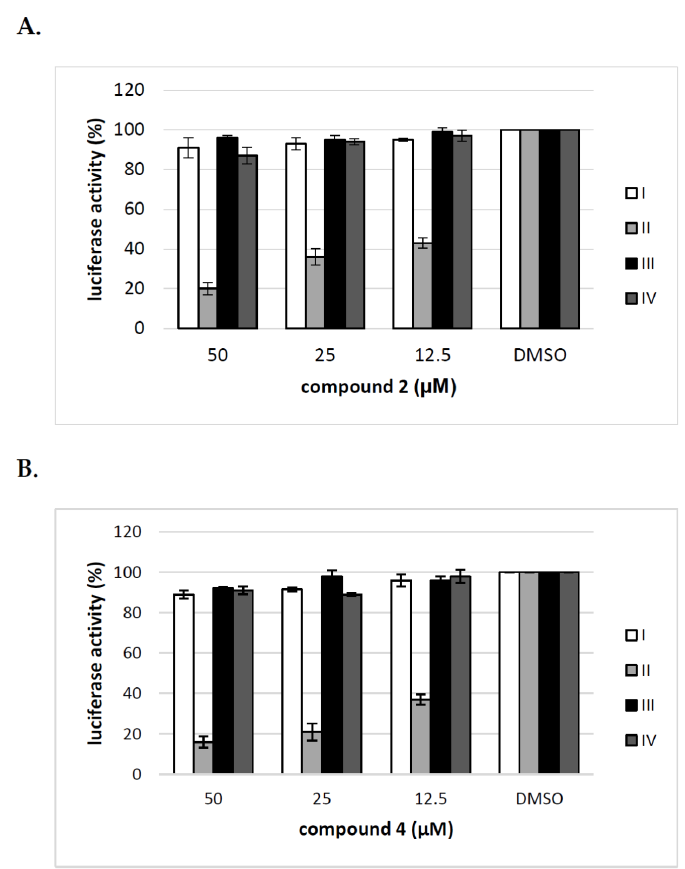
Figure 7. Analysis of the effect of compound 2 and 4 on different stages of HCVpp